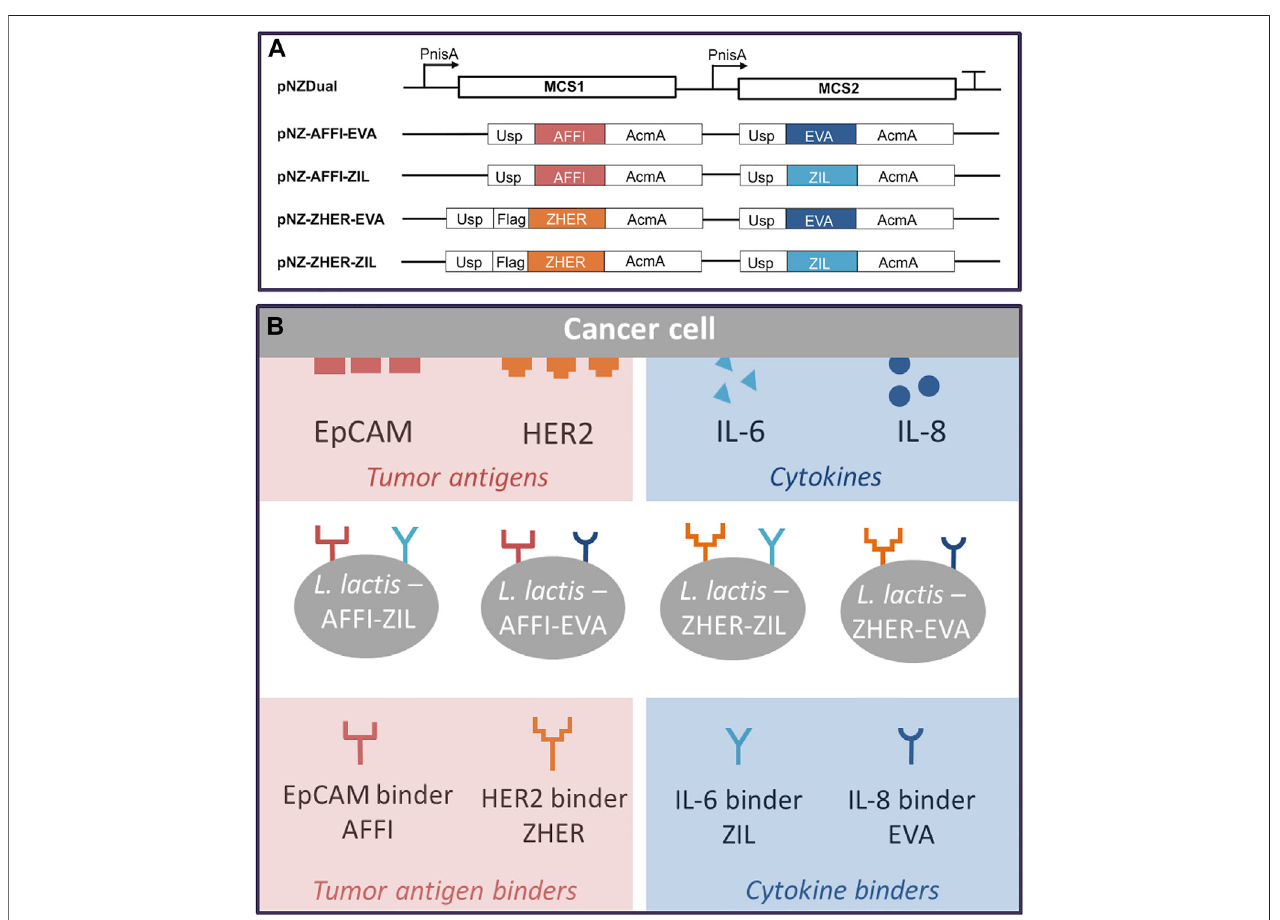
FIGURE2| SchematicrepresentationofthegeneconstructsthatwereclonedintothelactococcalpNZDualplasmidforco-expressionandsimultaneousdisplayof tumor antigen binding proteins and cytokine binding proteins on the surface of the Lactococcus lactis bacteria (A) , with the resulting recombinant L. lactis strains (B) . AFFI, gene encoding EpCAM-binding af fi tin (183 bp); ZHER, gene encoding HER2-binding af fi body (174 bp); EVA, gene encoding IL-8-binding evasin-3 (243 bp); ZIL, gene encoding IL-6-binding af fi body (174 bp); Usp, gene encoding Usp45 signal peptide for secretion into the growth medium (84 bp); AcmA, gene encoding the C-terminal portion of the AcmA protein containing three LysM repeats for surface anchoring (642 bp); FLAG, epitope tag sequence; MCS, multiple cloning site; PnisA, nisin